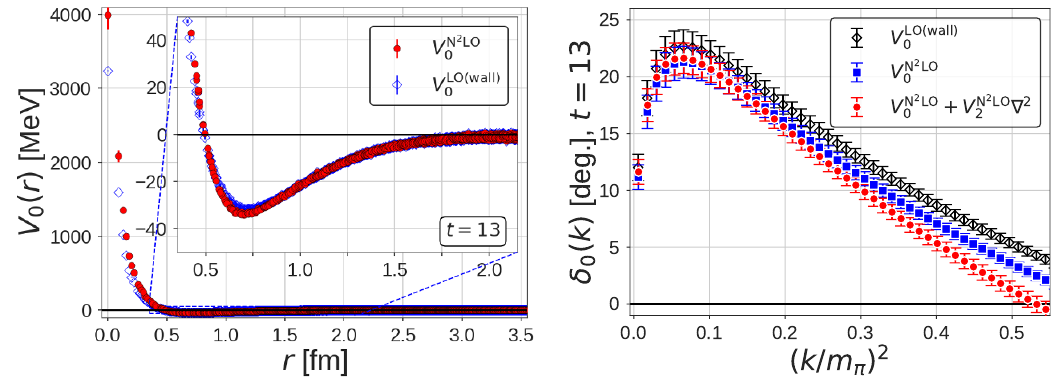
Figure 5 . (Left) The LO (cid:4)(cid:4)( 1 S 0 ) potential at the N 2 LO analysis, V N 2 LO ( r ) (red circles), together 0 with the potential at the LO analysis for the wall source, V LO(wall) ( r ) (blue diamonds) at t=a = 13 0 on L = 64. (Right) The scattering phase shifts (cid:14) 0 ( k ) from V LO(wall) (black diamonds), V N 2 LO ( r ) 0 0 (blue squares) and V N 2 LO ( r ) + V N 2 LO ( r ) r 2 (red circles) at t=a = 13. Both (cid:12)gures from ref. 0 2